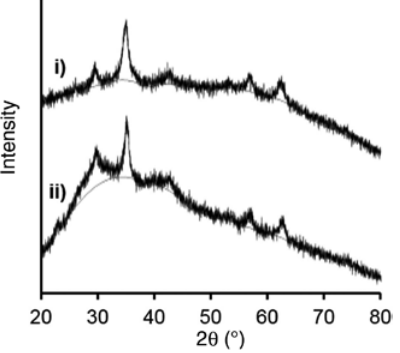
O and (ii) Fe 3 4